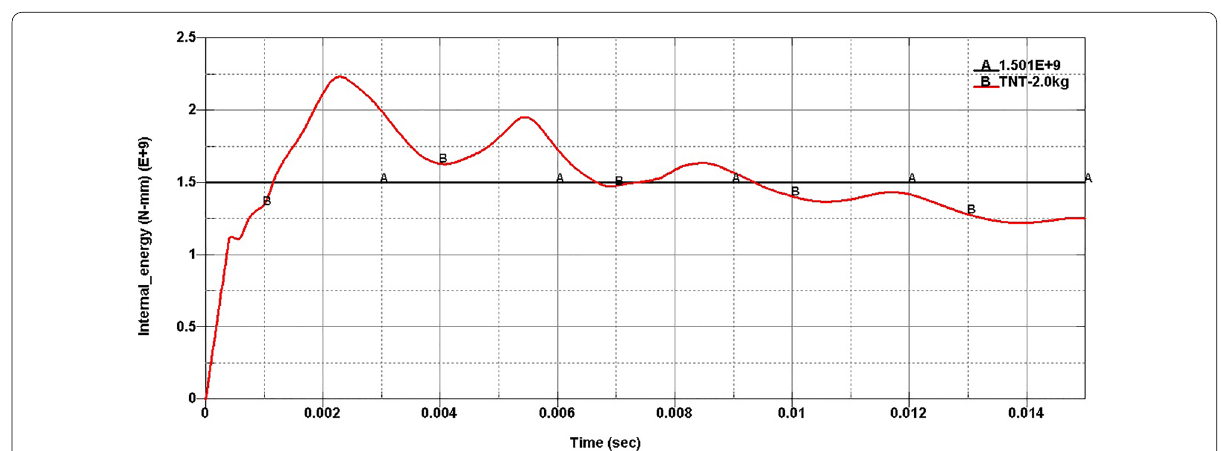
Fig. 19 TNT 2 kg afterburning start time and end